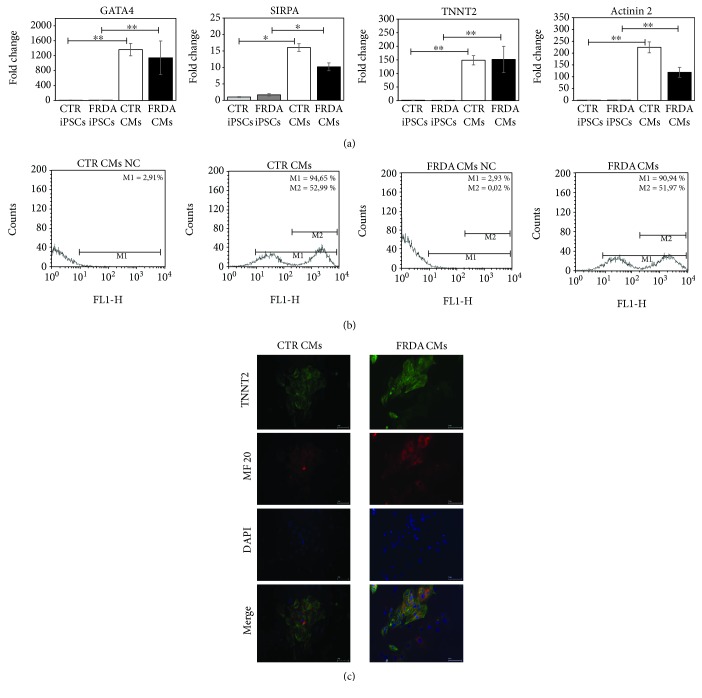
Characterization of CTR and FRDA iPSCs and iPSC-derived CMs. (a) Gene expression of four specific cardiac genes, GATA4, SIRPA, TNNT2, and actinin 2 characterized by qRT-PCR. Data were normalized with two housekeeping genes, β-actin and GAPDH; for each gene, the normalized expression value of CTR iPSCs was set to 1, and all other gene expression data were reported to that sample. PCR was run in triplicate; data are from four independent differentiation experiments and are expressed as mean ± SEM. ∗
p < 0.05; ∗∗
p < 0.01. (b) A representative flow cytometer analysis of CTR and FRDA CMs stained with TNNT2. NC negative control was stained with secondary antibody only; M1: percentage of TNNT2-positive CMs; M2: percentage of CMs highly positive to TNNT2. (c) A representative immunofluorescence image of CTR and FRDA CMs. TNNT2 is stained in green; heavy myosin chain (MF 20) is stained in red; the nuclei are stained with DAPI (blue). Scale bar 50 μm.